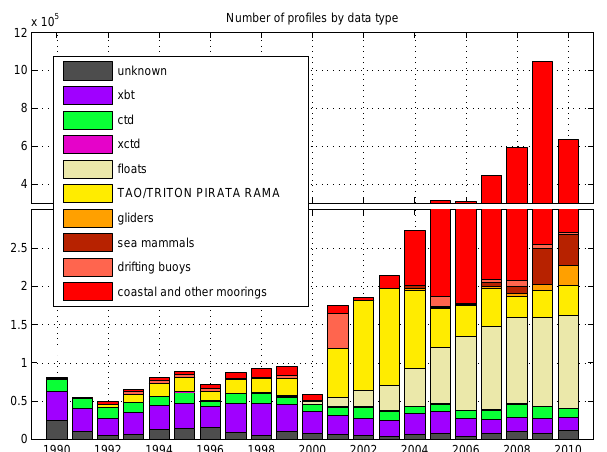
Fig. 3. Number of profiles divided by data type as a function of time.